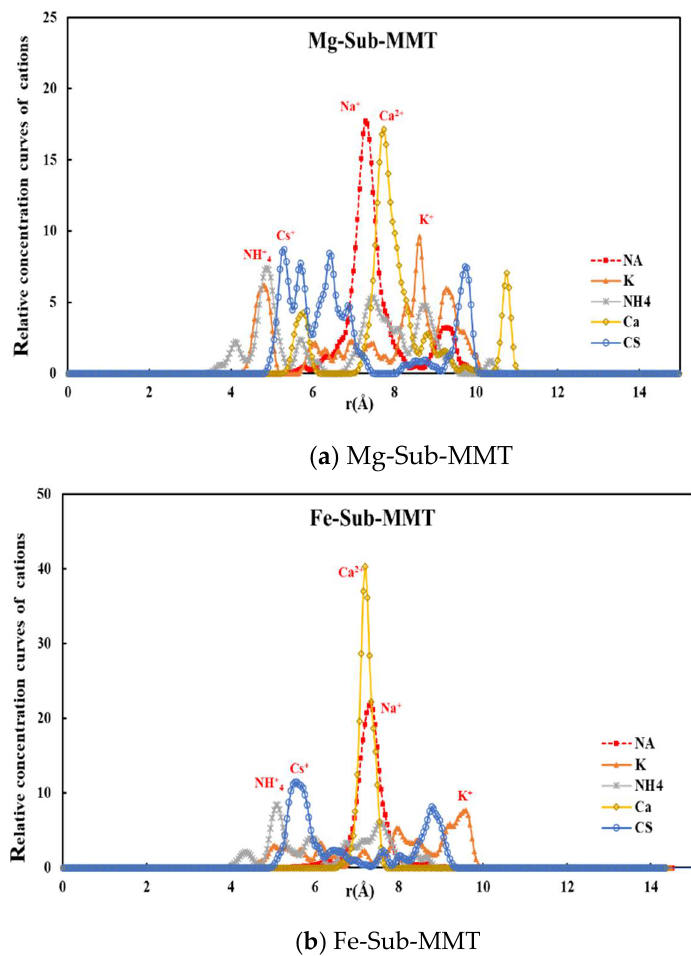
Figure 4. Z-axis relative concentration curves of counterion.